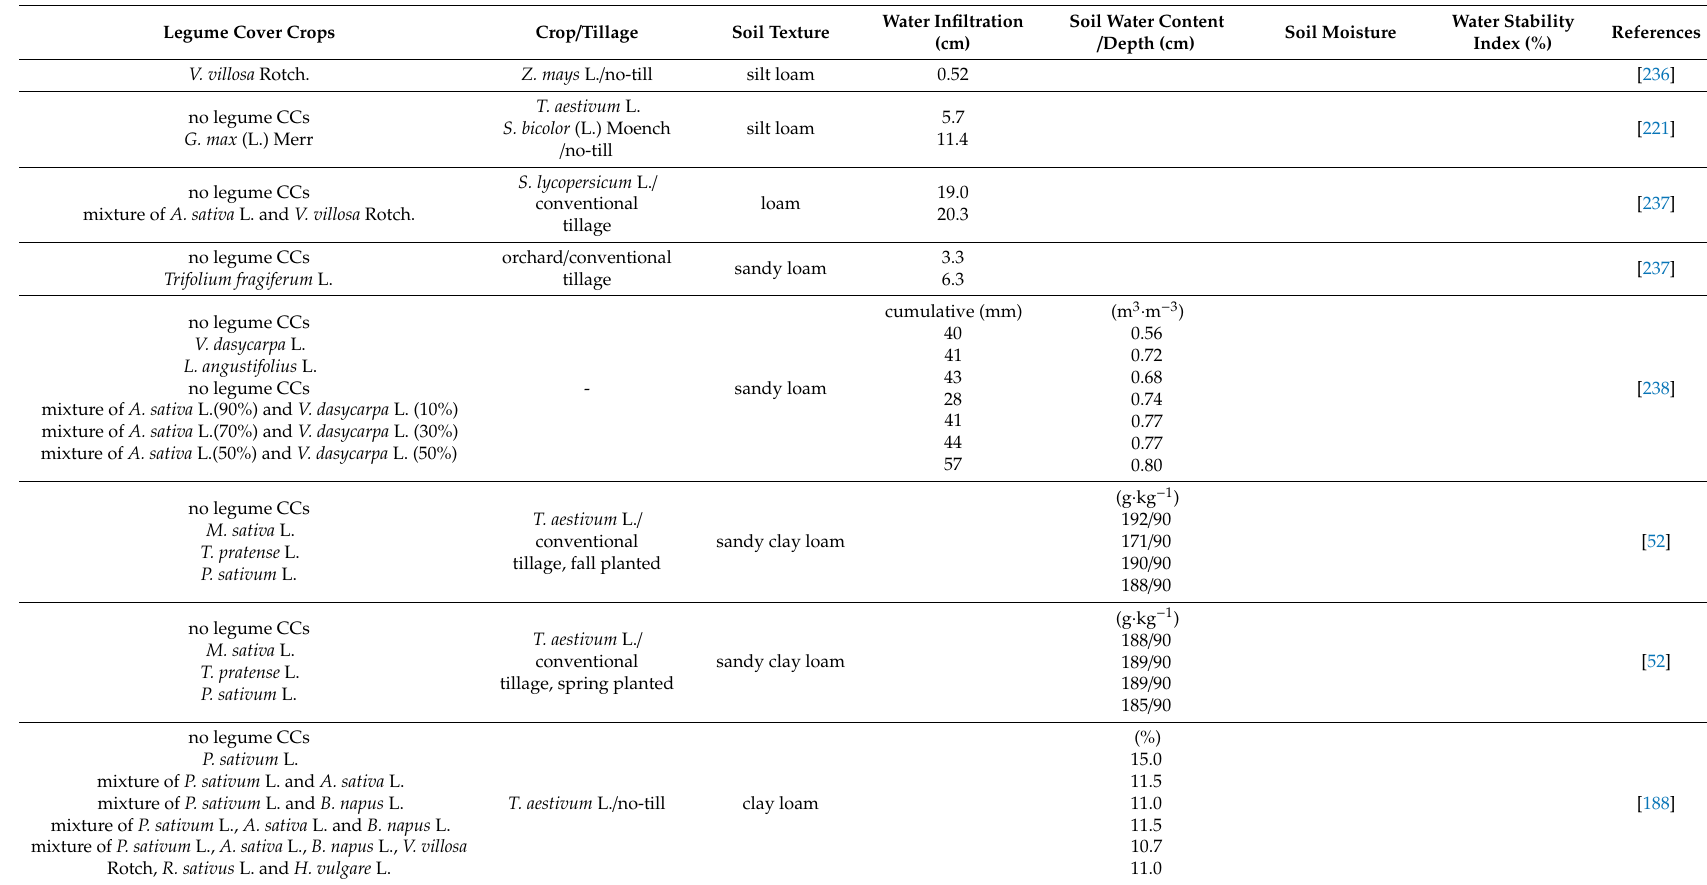
Table 4. E ff ect of legume CCs on soil water